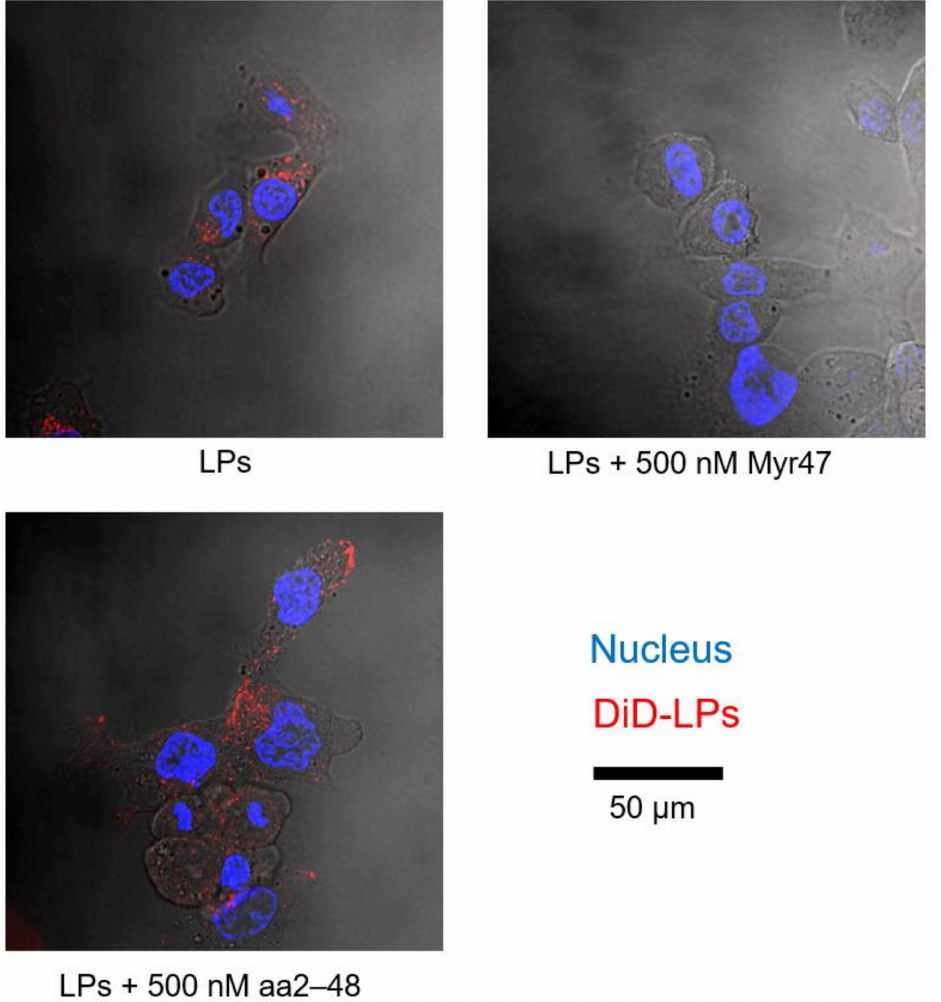
Figure 1. Inhibitory effect of Myr47 on the cellular LP uptake by Hep G2 cells (no NTCP expression). Hep G2 cells were incubated with DiD-LPs (10 µ g/mL) in serum-free DMEM containing Myr47 or its mutant (500 nM) for 3 h at 37 ◦ C, and then observed under confocal laser scanning microscopy. Nucleus (cyan) were stained with Hoechst 33342 (2 µ g/mL) and LPs (red) were stained with